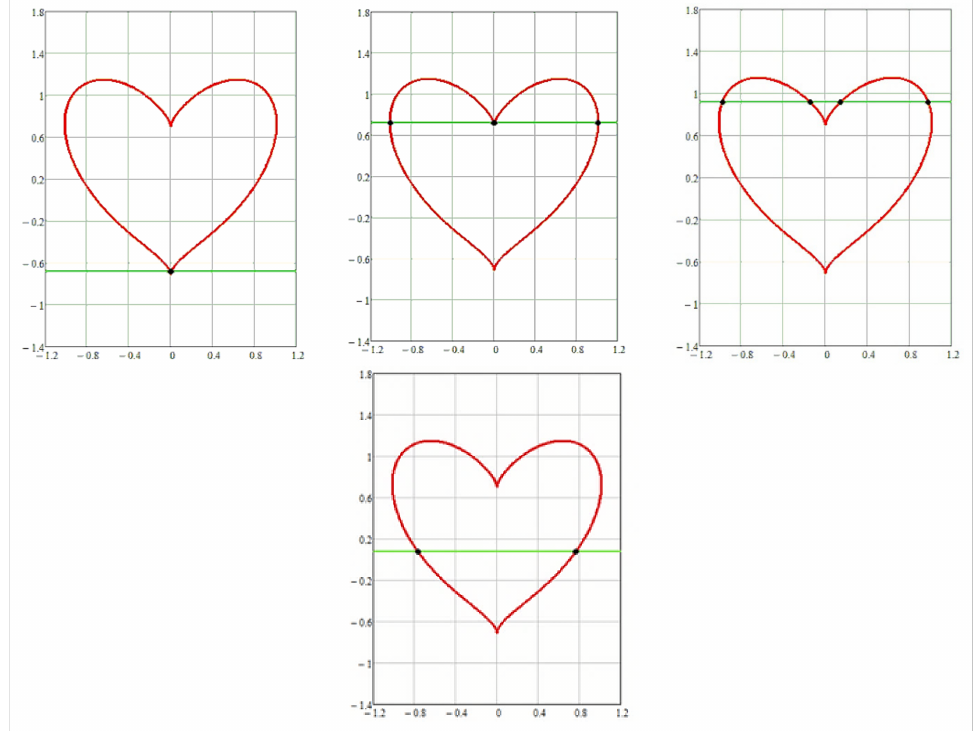
Figure 15. Animation frames in Mathcad